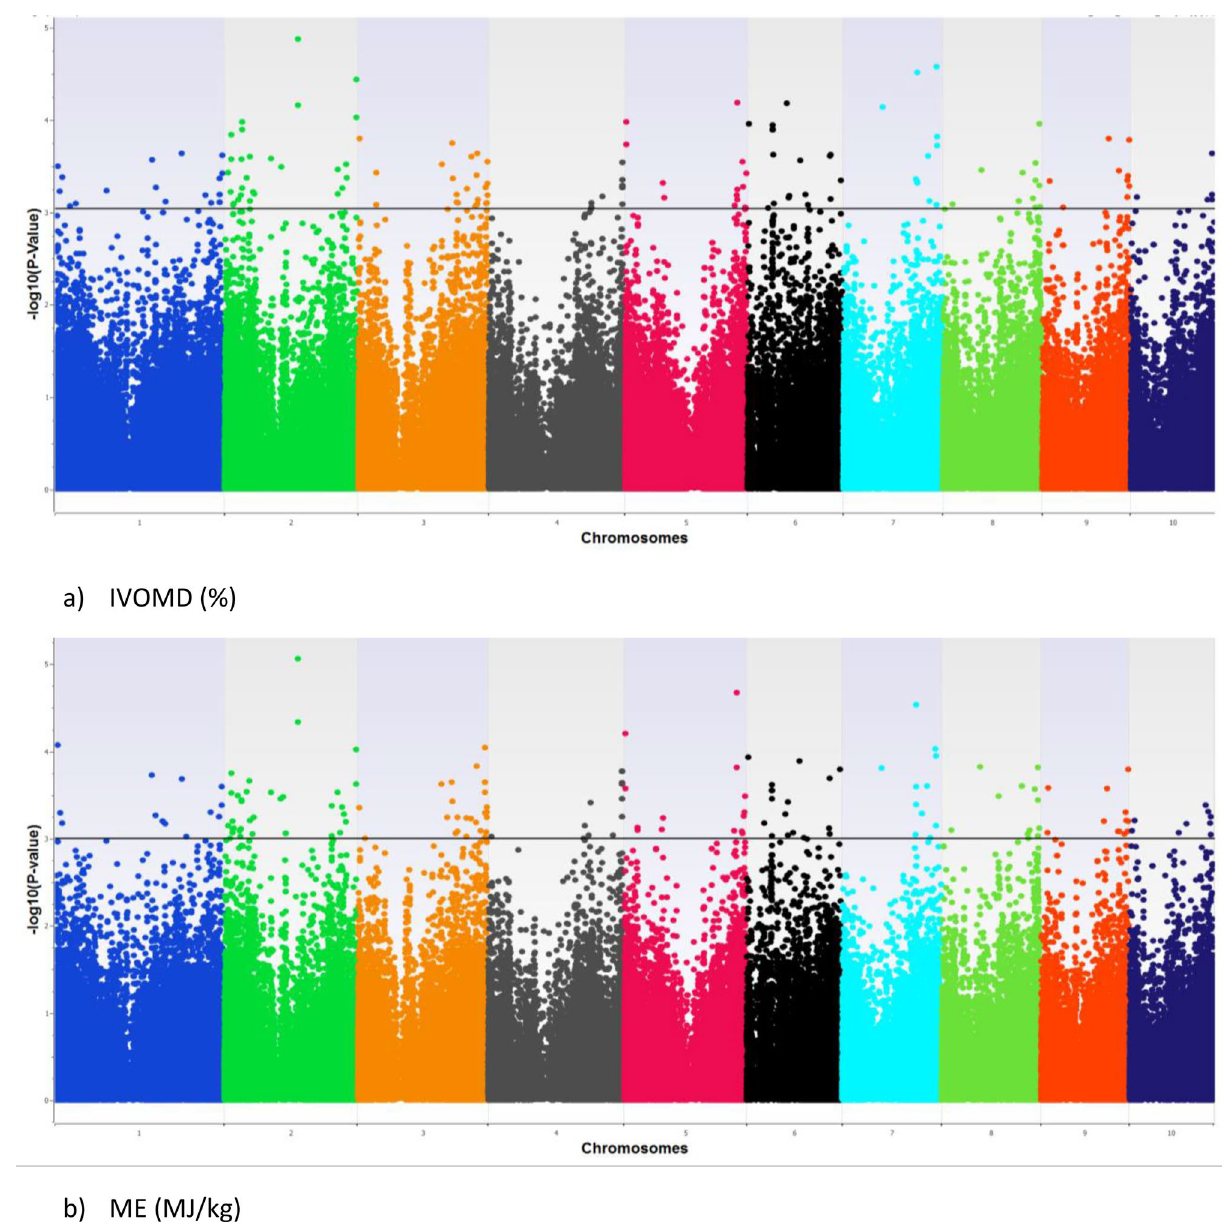
Figure 5. Manhattan plot depicting the association of SNPs for the two stover quality traits ( a ) IVOMD and ( b )